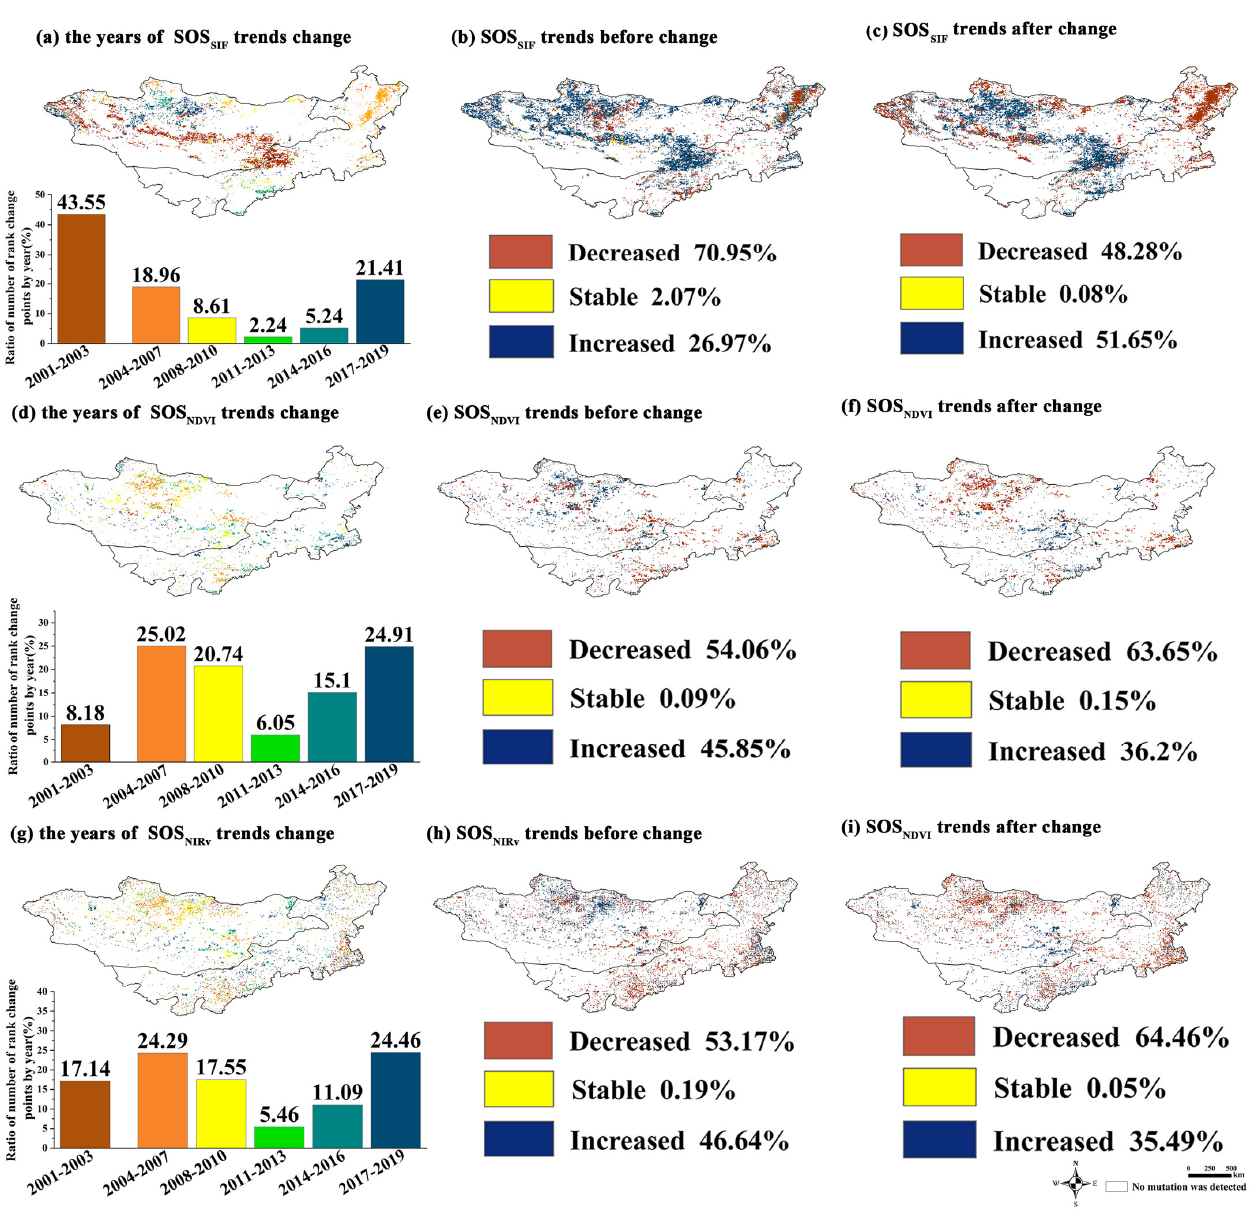
Figure 6. The years when the SOS trends changed during the past 20 years, and a trend comparison before and after the change: ( a , d , g ) are the change-points years and the change proportions of SOS SIF , SOS NDVI and SOS NIRv, respectively; ( b , c ), ( e , f ) and ( h , i ) are the trends before and after the changes in SOS SIF , SOS NDVI and SOS NIRv , respectively.